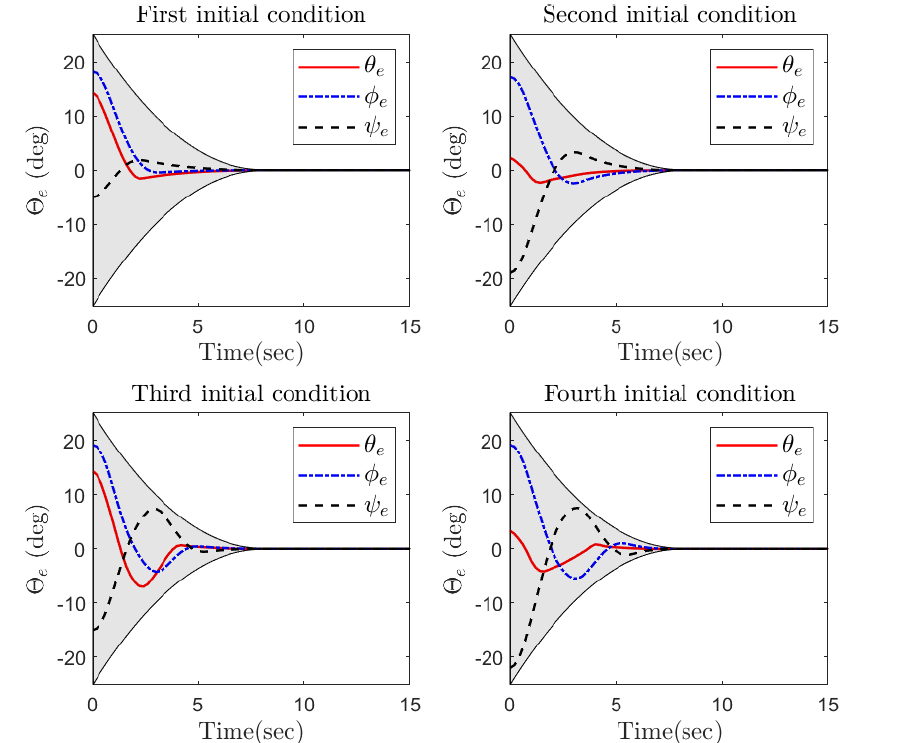
Figure 4. The attitude tracking error in Part